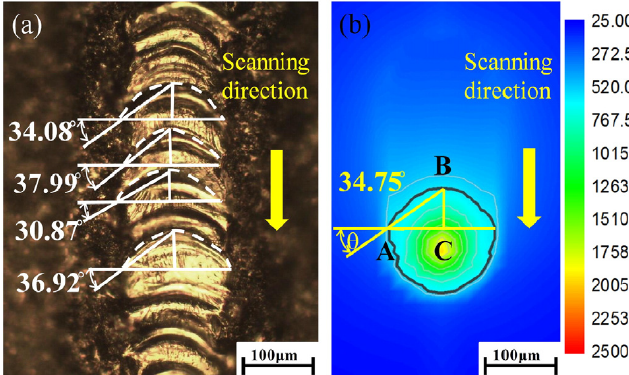
Figure 10. Ripple angle as indicator to examine track surface ( a ) experimental sample, ( b ) numerical simulation